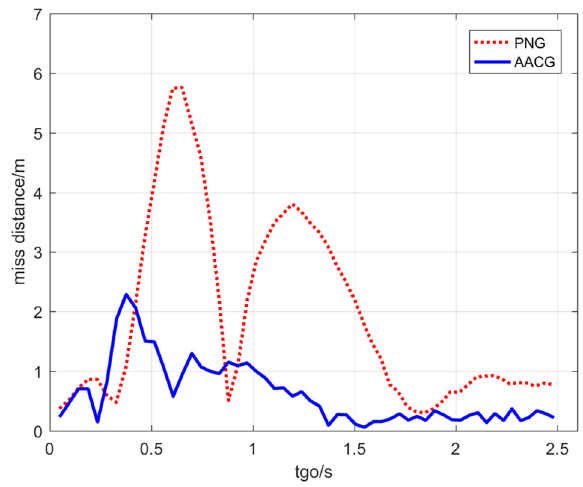
Figure 21: Aim point jumping t go – miss distance.